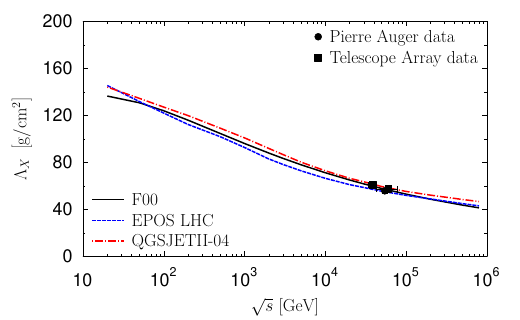
Figure 2. Attenuation length as a function of the center-of- mass energy for our F00 model (full line). EPOS LHC (dotted = c + d X max line) and QGSJETII-04 (dash-dotted line) predictions are taken (cid:31) (cid:30) · from [28]. Pierre Auger Collaboration measurements [30] are in- dicated by black circles while Telescope Array data [31] by black